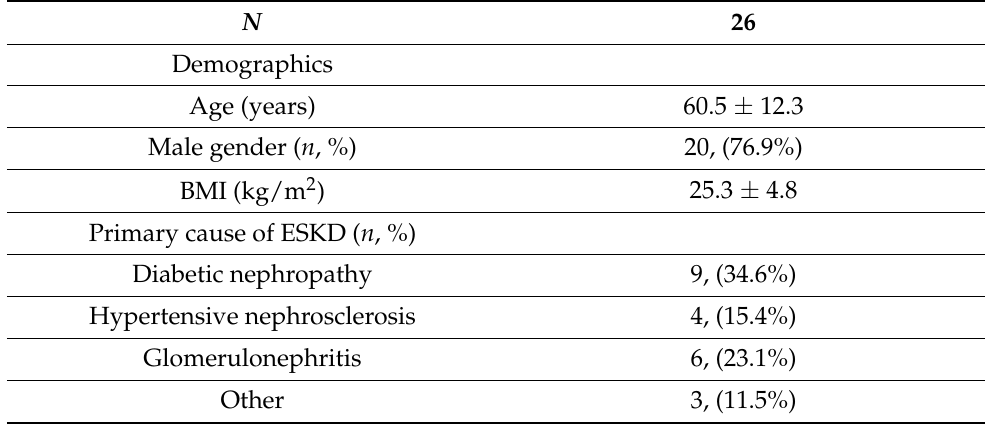
Table 1. Clinical and laboratory characteristics of study